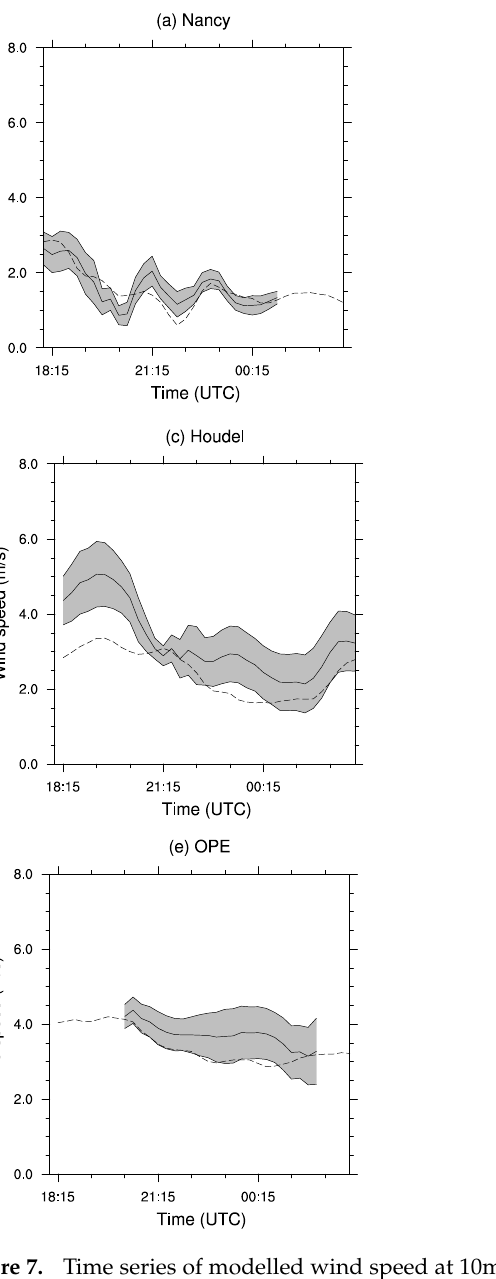
Figure 8. Same as Figure7 for the modelled wind speed at 10 m (left panel) and at 50 m (right panel).